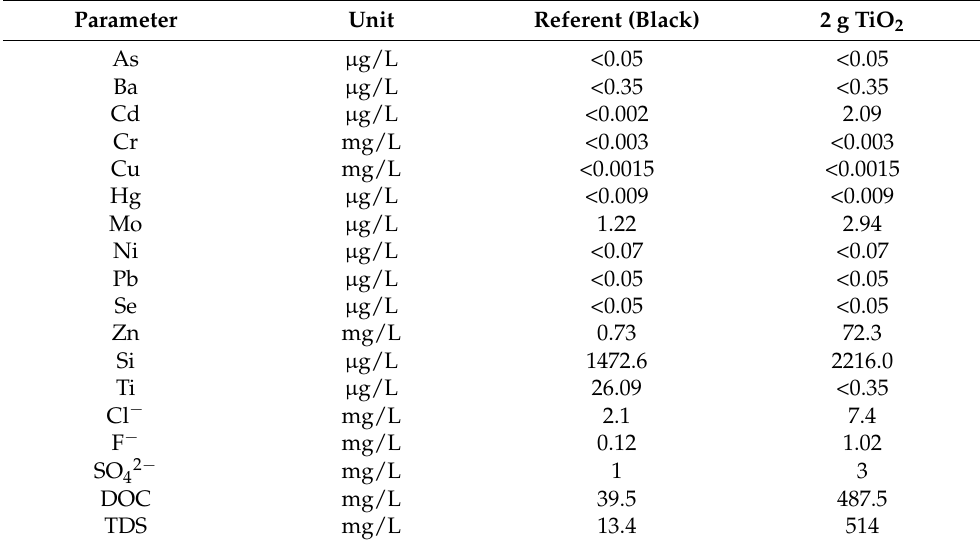
Table 3. Results of leaching test for black